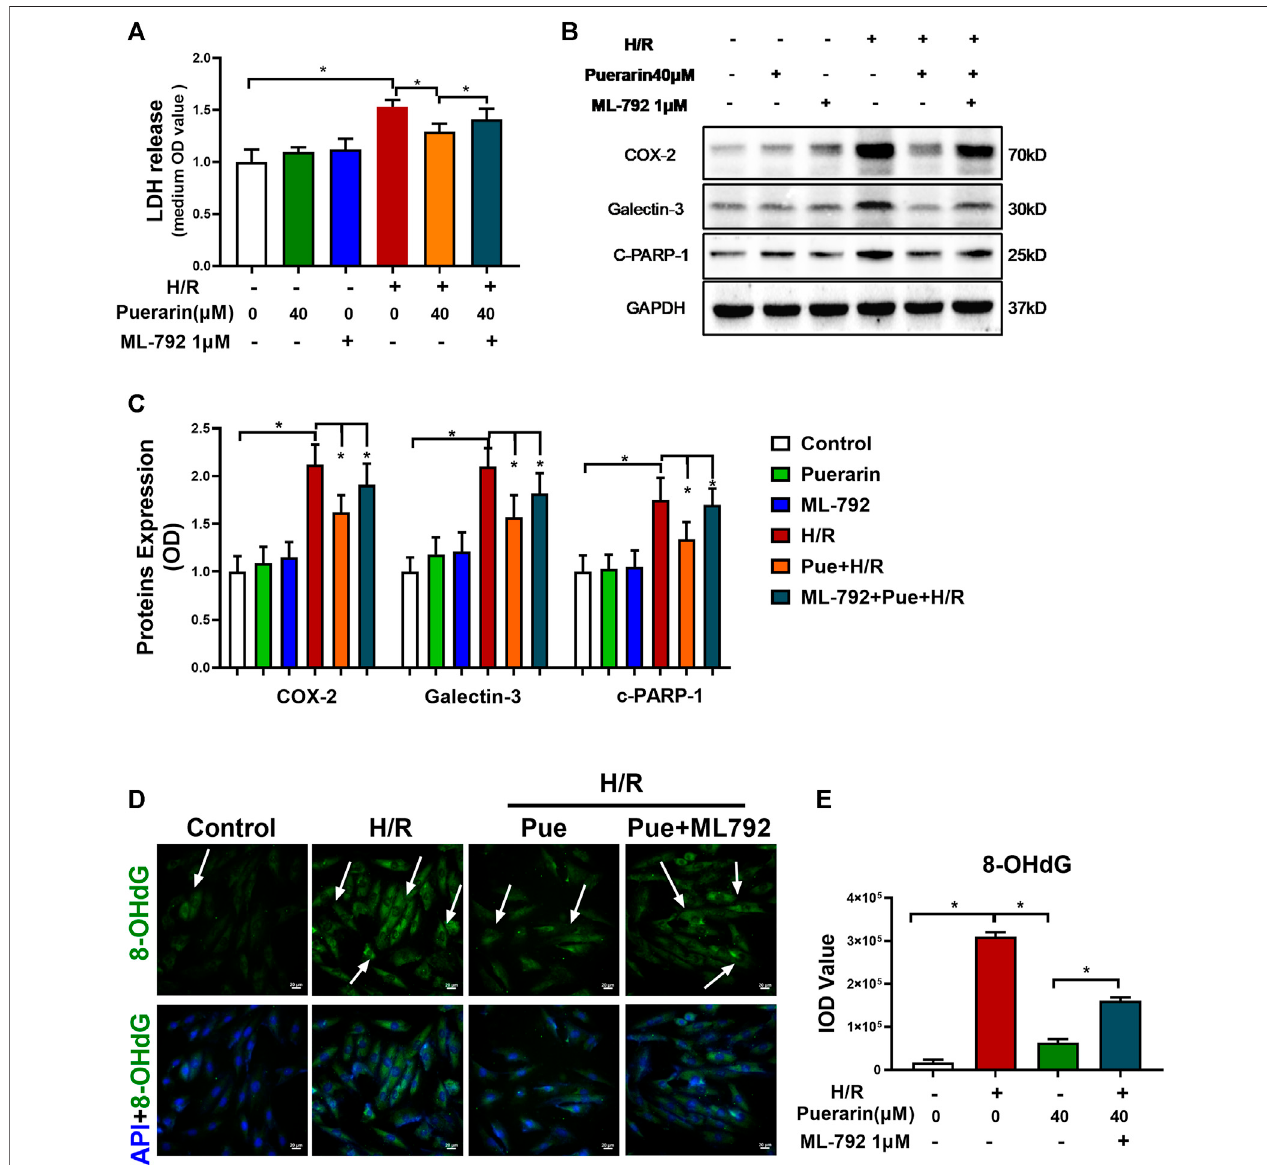
FIGURE4| PuerarinpromotedSUMOylationasapotentialcytoprotectivemechanismagainsthypoxia/reoxygenationchallenge. (A) DetectionofLDHreleasefrom H9c2cells.After1 htreatmentwithpuerarin-40 μ MandML-792-1 μ M,aloneorincombination,H9c2cellswereexposedtohypoxia(0.1%O 2 )for3 handreoxygenation for 24 h. LDH release was measured by theLDH cytotoxicity assaykit. (B) WesternblotanalysisforCOX2, galectin-3 and cleaved-PARP-1 expression.H9c2 cells were collectedandanalyzed byWesternblottingwithantibodiesagainstCOX2,galectin-3,cleaved-PARP-1. (C) Quanti fi cationofCOX2,galectin-3andcleaved-PARP- 1expression.Theblots inpanel Bwerequanti fi ed byadensitometric method. Theresults wereshown asmean ± SD( n (cid:2) 3). * p < 0.05. (D) Immunostainingofcellular 8- OHdG. H9c2 cells were probed with primary anti-8-OHdG antibody and visualized with Alexa Fluor 488-conjugated secondary antibody, whereas the cell nuclei were stained with DAPI. Scale bar, 50 μ m. (E) Quanti fi cation of 8-OHdG formation. The results were presented as mean ± SD ( n (cid:2) 3). * p < 0.05.